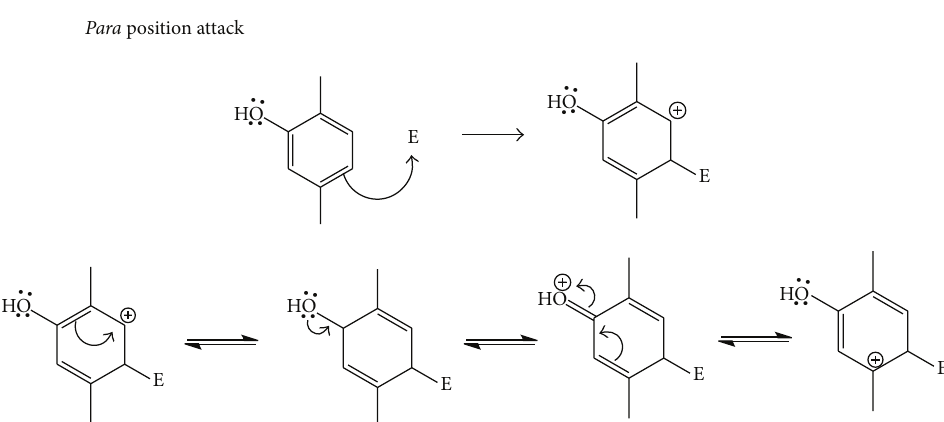
IOH OH NaI NaClO